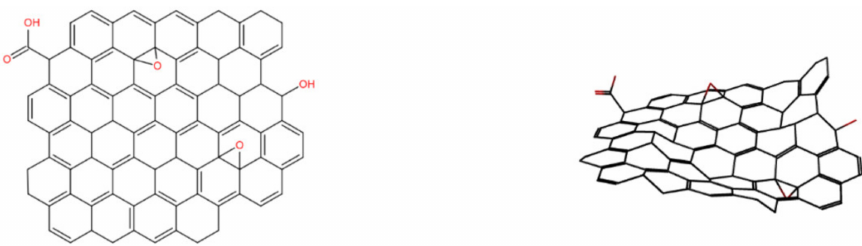
Figure 2. Plane structure ( left ) and solid structure ( right ) of rGO (bond line